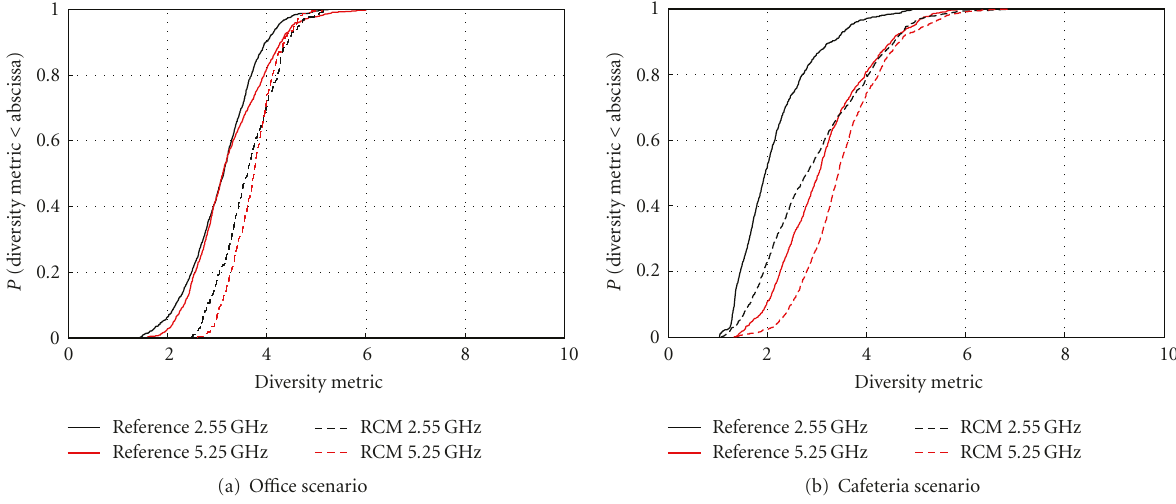
Figure 9: Model validation using the diversity